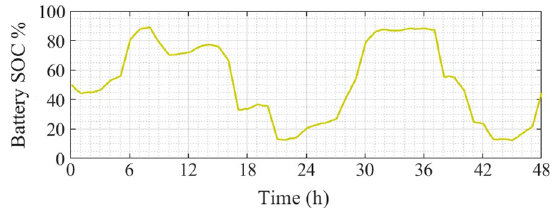
Fig. 6 SOC of battery during dispatch horizon